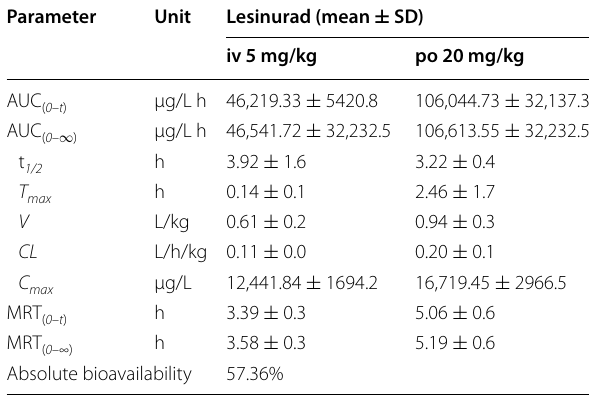
Table 4 The pharmacokinetic parameters of lesinurad in rat plasma after oral or intravenous administration